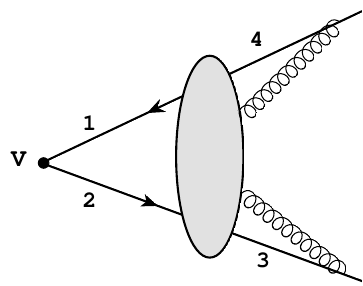
Figure 1 . All distinguished fermion propagators available for a generic vector (and scalar) vertex